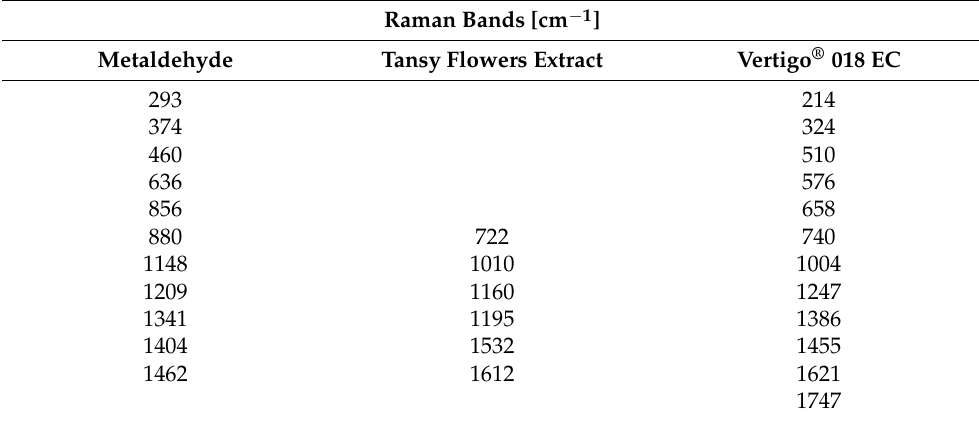
Table 3. The maxima of Raman characteristic bands of